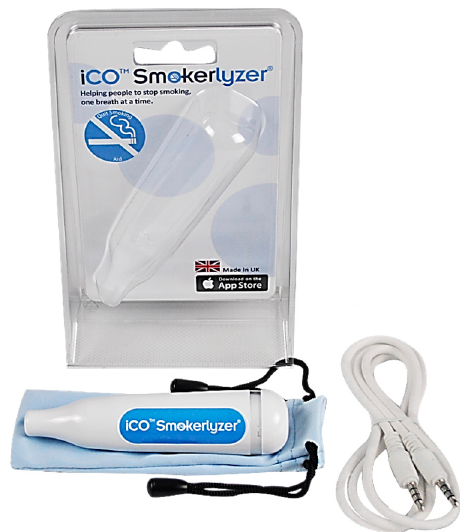
Figure 1. iCO™ Smokerlyzer ® developed by Bedfont ® Scientific Ltd., which was used as a prompt in the study to elicit views and preferences regarding a personal CO monitor and its potential use. The device uses a cable to connect to a smartphone through the phone’s audio jack. Images sourced from [40] with permission from Bedfont ® (© 2017 Bedfont ® Scientific Ltd.).